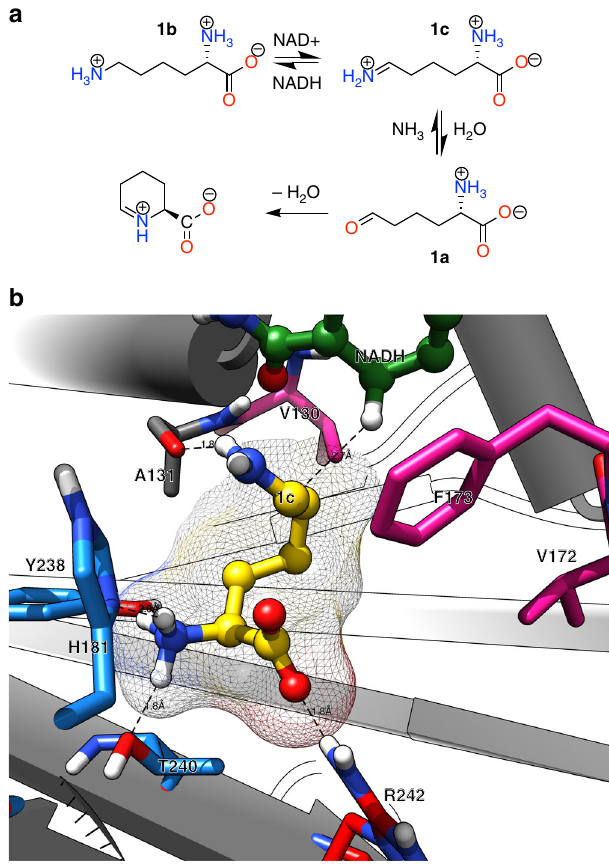
Fig. 1 Model of the active site of the ε -deaminating L -lysine dehydrogenase from G. stearothermophilus . a Schematic representation of the reactions undergone by the natural substrate 1b . b Model of the active site containing its natural substrate 1c . Residues H181, Y238 and T240 (in cyan) appear to stabilise the alpha NH 3 + group, whereas R242 appears to interact with the COO − of the substrate. Residues V172, F173 and V130 create a hindered hydrophobic environment. All highlighted residues are amenable targets for protein engineering